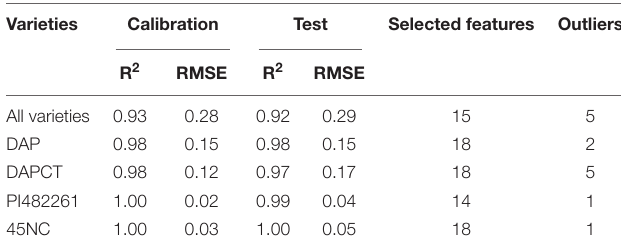
TABLE 7 | Multiple linear regression model performance based on all and individual watermelon varieties. Varieties Calibration Test Selected features